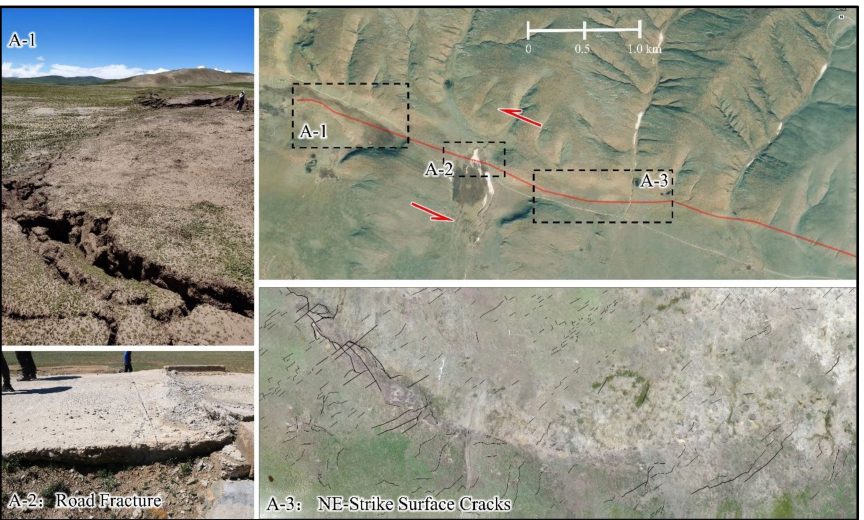
Figure 7. The surface cracks caused by the Maduo earthquake found in the northwest segment of the seismogenic fault in the field investigation. The red line indicates the surface trace of the detected co-seismic fault, the black lines denote the distinguished surface cracks from the UAV images, the red dashed rectangles show three significant surface rupture zones, and the red arrows show the surface motion direction. Localities A1–A3, see Figure